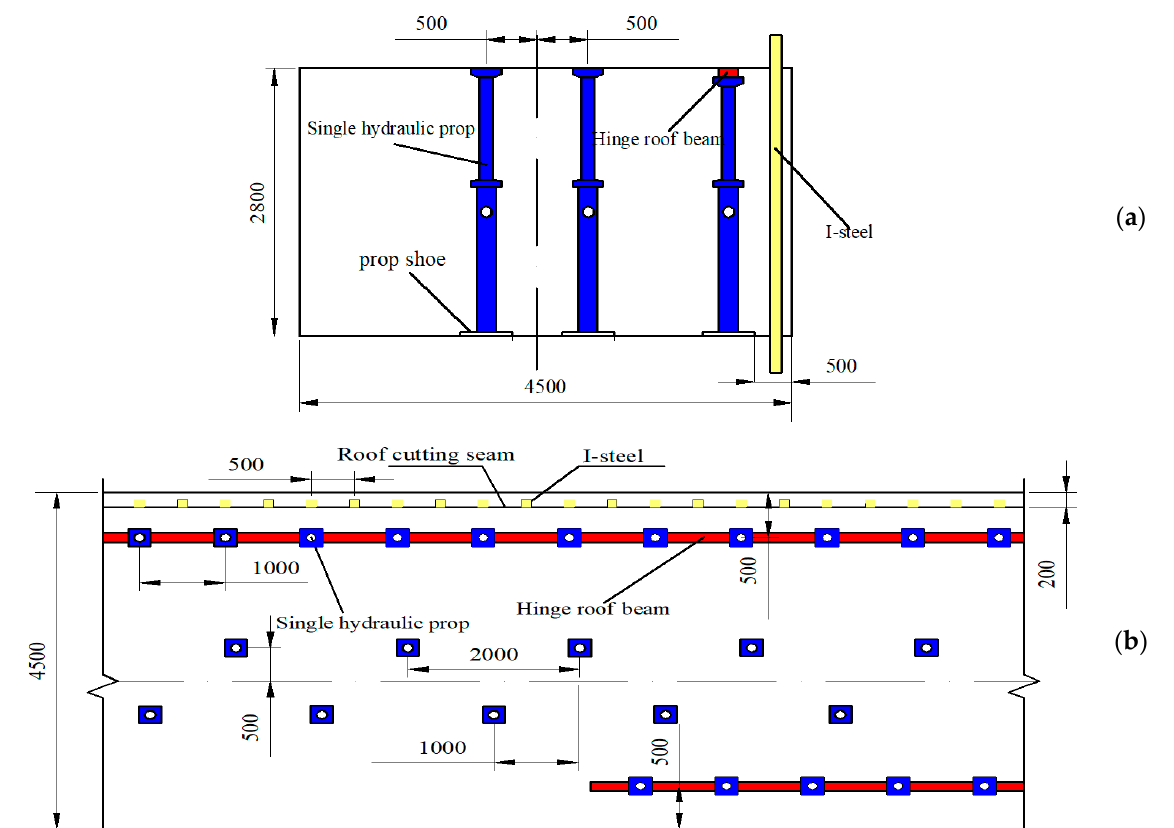
Figure 17. Schematic diagram of the delayed temporary support. ( a ) Support section, ( b ) Support planar.